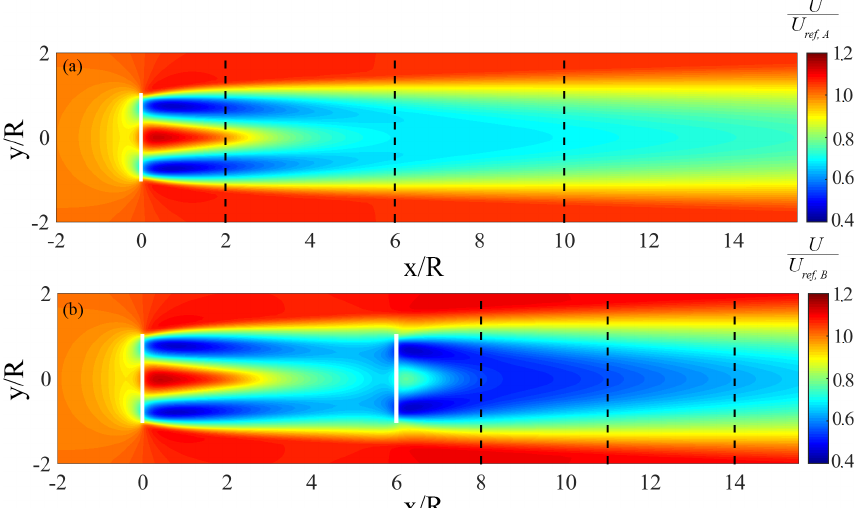
Figure 5. Normalized axial velocity contours for the k - ε turbulence model using the polynomial thrust distribution. (a) One model wind turbine, case A, and (b) two in-line model wind turbines, case